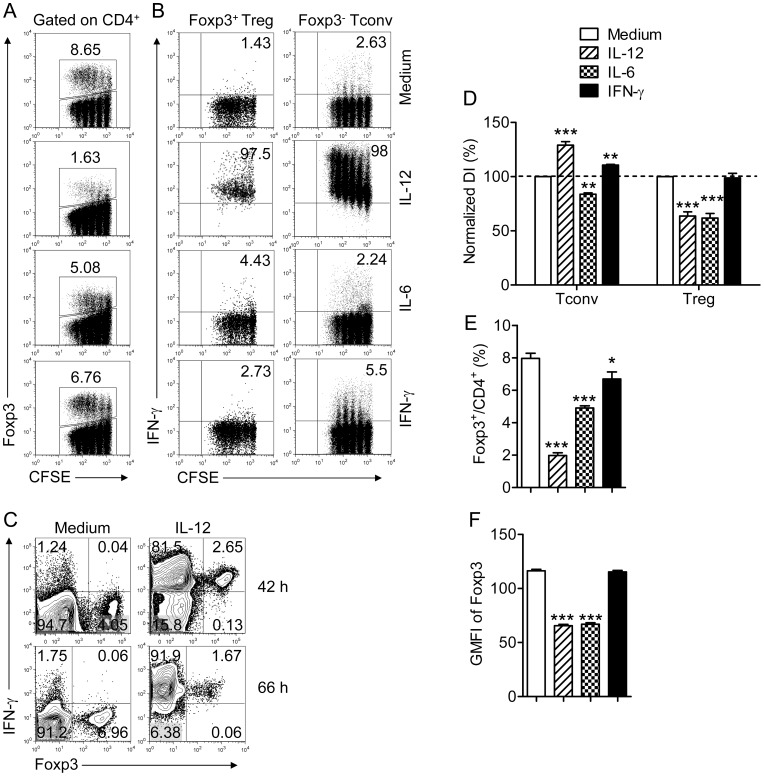
IL-12, but not IL-6 or IFN-γ induces IFN-γ expression by Foxp3+ Tregs.Lymphocytes were prepared from lymph nodes of naïve B6 mice, labeled with CFSE and stimulated with anti-CD3 mAb and the indicated cytokine for 66 hr. Cells were then stimulated with PMA and ionomycin for 4 hr. (A) Percentage and CFSE dilution of Foxp3+ Tregs in the CD4 T cell population. (B) IFN-γ expression by Tconvs (Foxp3−) or Tregs (Foxp+) after exposure to IL-12 (1 ng/ml), IL-6 (25 ng/ml) or IFN-γ (100 ng/ml). (C) IFN-γ expression by Tconvs (Foxp3−) and Tregs (Foxp+) after exposure to IL-12 for 42 or 66 hr. (D) Division indices (DI) were calculated for Tconvs and Tregs and normalized to the groups treated with medium. Data are from three independent experiments. (E) Percentage of CD4 T cells expressing Foxp3 after treatment. Data were acquired from 4–9 independent experiments. (F) Geometric mean fluorescent intensity (GMFI) of Foxp3 in Tregs after indicated treatment, measured in triplicate. Data are from one experiment representative of 3 independent experiments. *P<0.05, **P<0.01, ***P<0.001 compared to cells exposed to medium, Student’s two-tailed paired t tests (D) or un-paired t tests (E, F).